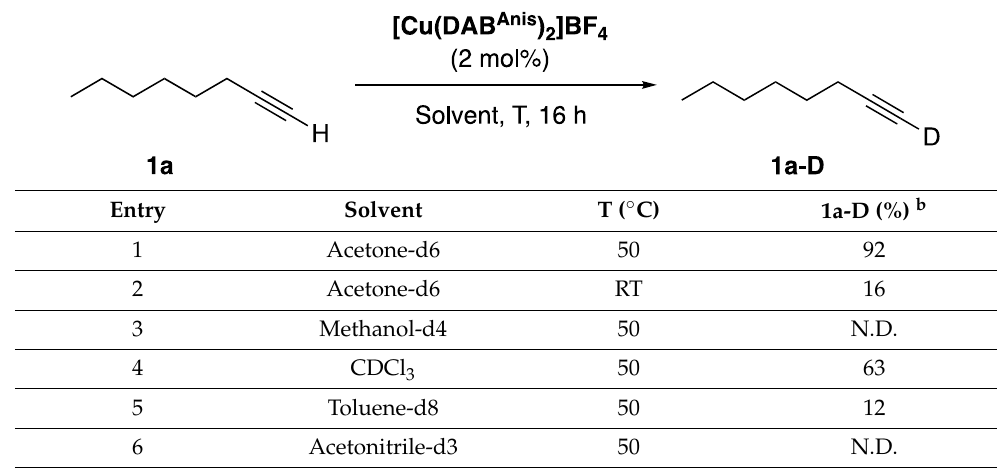
Table 2. Final optimisation a .